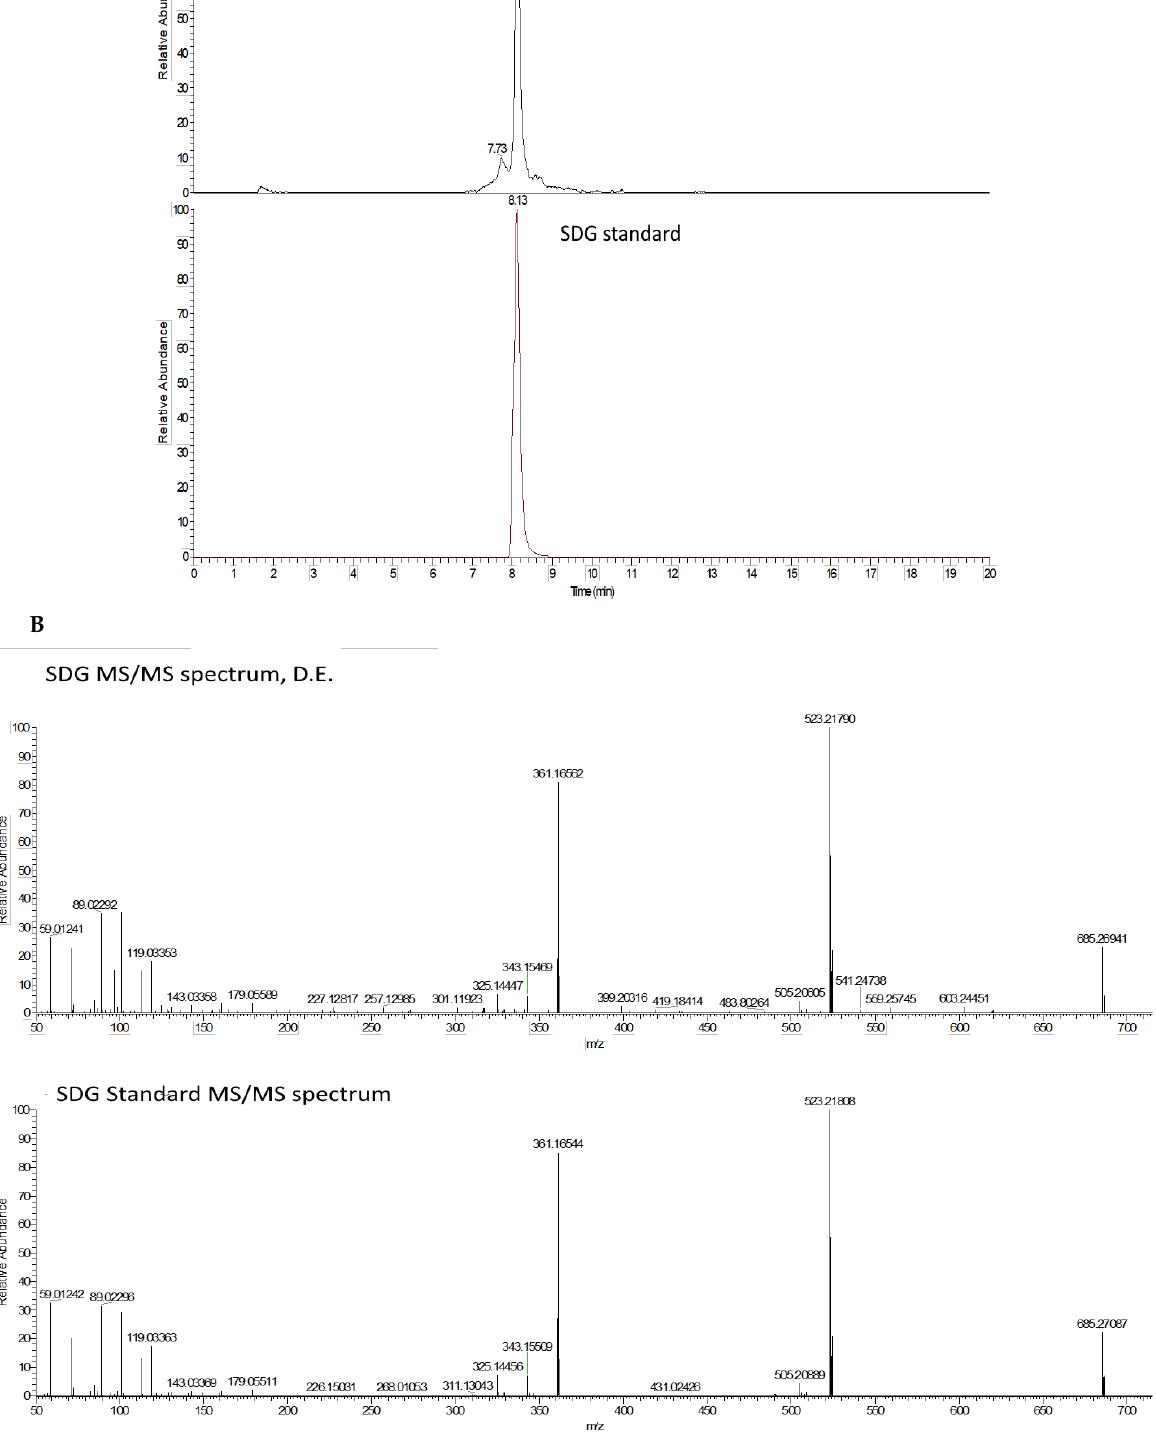
Figure 4. Comparison of retention time of SDG in D.E. and of SDG pure standard ( A ). Comparison of MS/MS spectra of SDG in dry extract and of SDG pure standard ( B ).